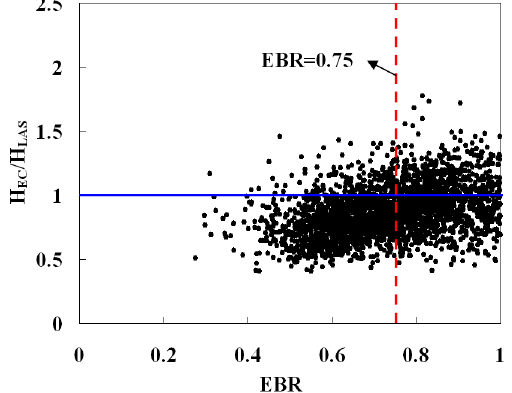
Fig. 8. H EC /H LAS scatters according to the Energy Balance closure Ratio (EBR) in the 30-min data at AR when H LAS and H EC > 50Wm − 2 (11 March to 31 October 2008, and 1 January to 30 June 2009, 30-min).